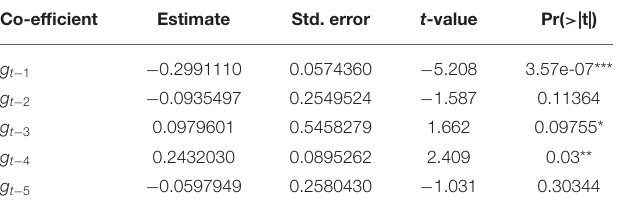
Figure 6 shows the effects of the IR function in the VAR model. The Impulse Response line is black, while the red lines represent 95 percent coefficient intervals. IRF at all instances in the 95% confidence coefficient range. The responsiveness of the Pakistani rupee to US-dollar to the amount of each day COVID-19 tests can be examined. Figure 6 is the IR function of the Pakistani rupee against the US-dollar to the amount of daily COVID-19 tests. One standard error stunning from the COVID-19 daily tests of the Pakistani Rupee US-dollar immediately have significant impacts, declines between 1 and 3 days in the negative zone and then steadily rises to 4th day in the positive zone and these variations persist until the 10th day means that the graph shows no stability. As a result, variations to the COVID-19 daily tests would have a long-term effect on Pakistan’s rupee against the